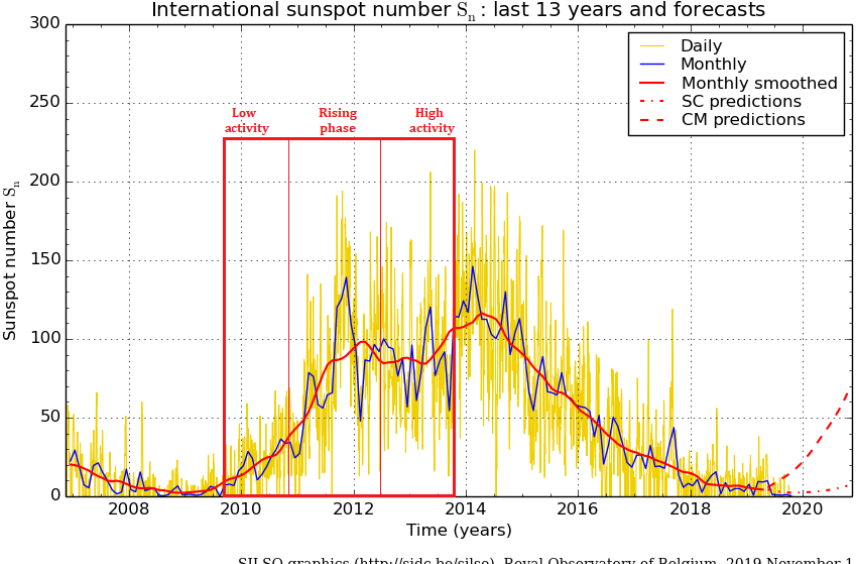
Figure 2. GOCE dataset in the context of solar cycle 24. The inset shows the data span, further divided into low activity (from mission start), medium activity (rising phase of solar cycle 24, from 24 September 2010) and high activity (solar cycle 24 stationary phase of high activity, from 4 July 2012), which mostly coincides with the altitude-lowering phase of the mission, starting 1 August